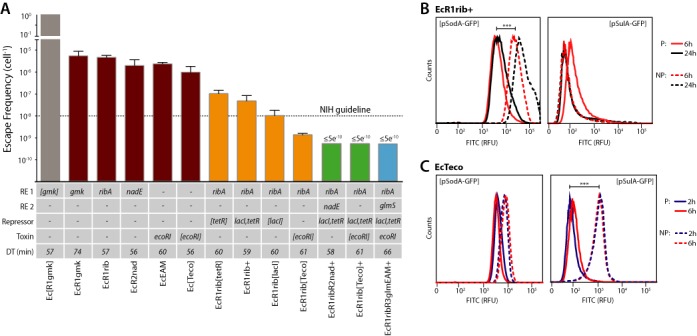
Layering of multiple safeguards reduces escape. (A) Escape frequencies (n = 3, ±SD) on solid media for strains containing one (red), two (orange), three (green) or four (blue) layers of genetic safeguards. NIH guidelines for work with engineered microorganisms advise a 10−8 escape frequency (11) (dotted horizontal line). Strains are characterized by ribo-essential gene (RE 1 or 2), presence of supplemental repressors, presence of a toxin and doubling time (DT) in minutes. Plasmid-based ribo-essential gmk safeguard (gray) does not confer containment. Square brackets denote plasmid-based constructs. Limit of detection for solid media is ∼5 × 10−10. Flow cytometry shows fluorescence from sodA and sulA promoters in EcR1rib+ (B) or EcTeco (C) when grown in non-permissive media (dashed) versus permissive (solid) media for 2 (purple), 6 (red) or 24 (black) h. *** denotes P ≤ 0.001, Student's one-tailed t-test with Welch's correction.